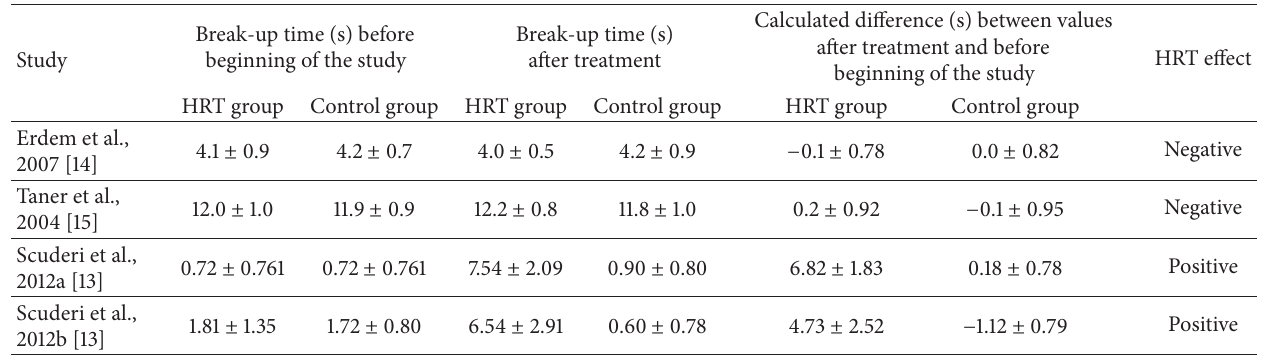
Table 4: Break-up time results of the included studies.